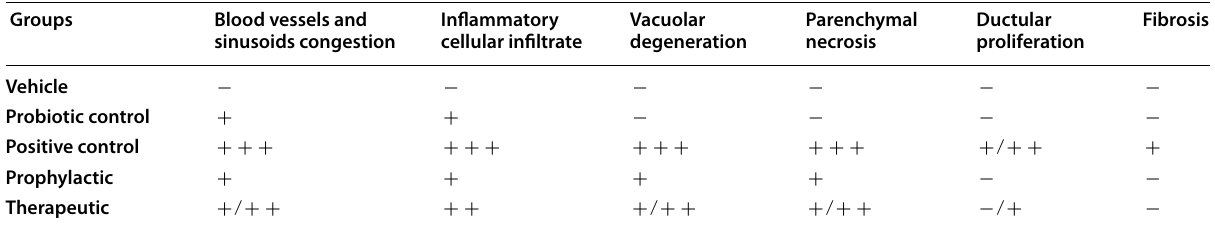
) normal, (0/ ) normal or mild, ( − +